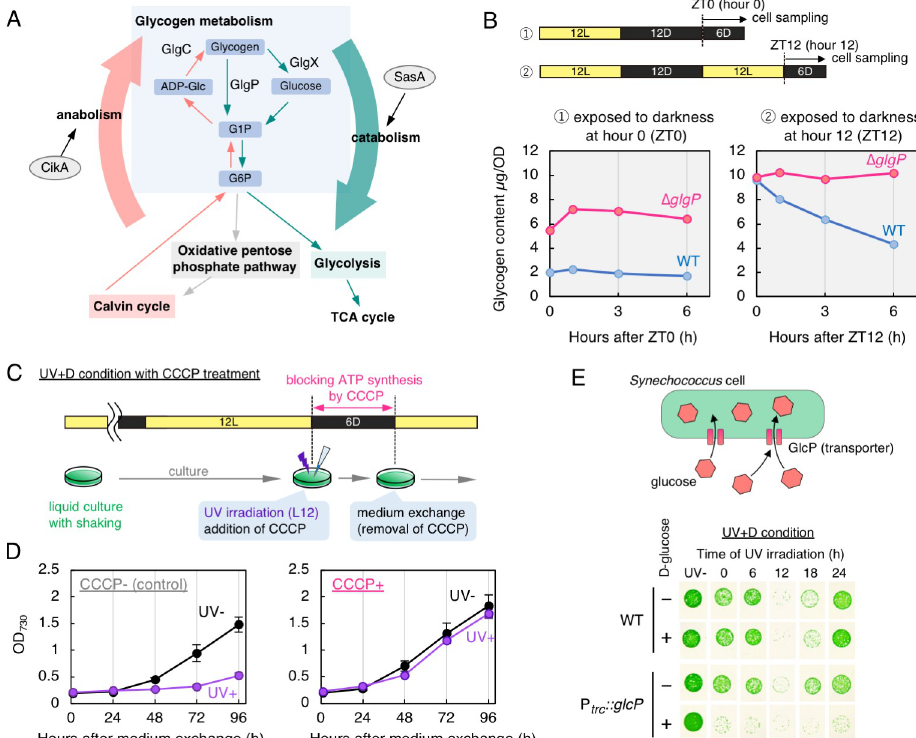
Fig 5. Glycogen and related metabolism affect circadian control of UV-C resistance. (A) A simplified diagram of the glycogen-related metabolic pathways (G1P, glucose-1-phosphate; G6P, glucose-6-phosphate; ADP-Glc, adenosine diphosphate glucose). GlgP is the core enzyme involved in glycogen degradation. SasA and CikA activate the catabolic and anabolic metabolic pathways, respectively, through mediating the timing information from the core oscillator to transcriptional machinery to control gene expression. (B) Quantification of glycogen content in WT and Δ glgP ( glgP - null) strains. Cells were exposed to darkness and then harvested at each timepoint. Left and right panels show the dynamics of glycogen content when the cells were transferred into darkness at hour 0 and 12 in LL, respectively. Hours in the dark is shown on the horizontal axis, and glycogen content is shown on the vertical axis. The glycogen contents are normalized by OD 730 unit of harvested cells. (C) A schematic representation of the experiment. UV-C irradiation and dark exposure was performed at hour 12 in LL. During the darkness, CCCP was added to the culture. At the end of darkness, CCCP treatment was terminated by washing cells with fresh BG-11 media. (D) Growth curves of UV-C irradiated cells. Hours after medium exchange are shown on the horizontal axis, absorbance at 730 nm of cell culture is shown on the vertical axis as an index of cell growth ( n = 3). Error bars represent standard deviation. Left panel shows the results in negative control without CCCP treatment. Right panel shows the results in the presence of 10 μ M CCCP. UV- and UV+ represent with and without UV exposure, respectively. (E) Effects of UV-C irradiation on the strain genetically modified to uptake glucose. A schematic representation of modified strain and its function are illustrated (upper). In the P :: glcP strain, the glucose transporter gene was expressed with a WT background. Each image trc represents the growth following the UV irradiation under the UV+D condition. The symbols “–” and “+” indicate the absence and presence of D-glucose, respectively. Both with and without D-glucose, experiments were performed in the presence of 1 mM IPTG. Representative data of three independent experiments are shown.